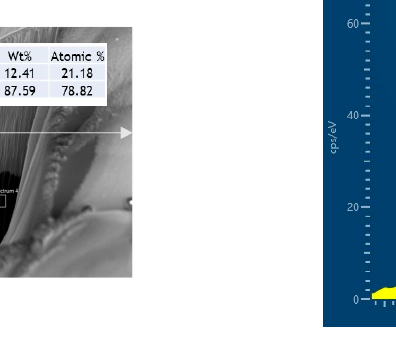
Figure 12. SEM and FIB-SEM examinations of the coating. ( a ) Cross-sectional cut of the coating observed by SEM, showing uniform thickness of the coating except for the edges, where the thickness is lower. However, no underlying corrosion events or discontinuities are observed in the coating impervious to moisture. ( b ) FIB-SEM observations allowed us to quantify the total thickness of the coating, in the order of 20 µm, and the thickness of the individual NiP and pure Ni constituent layers, respectively. ( c ) The EDS analysis in a selected area adjacent to the C f shows the signal of both Ni and P for the layer closer to the substrate. Good wetting of the C f s by the coating is confirmed. ( d ) close view of the interface between the Al matrix and the C f s, confirming good wetting by the NiP deposit and limited unfilled cavities. ( e ) Assessment of the Au coating, showing a typical thickness of 0.6 µ m (for a nominal thickness of 0.2 µ m). ( f , g ) EDS analysis of NiP deposit: the P content is in the order of 12.4 w%.